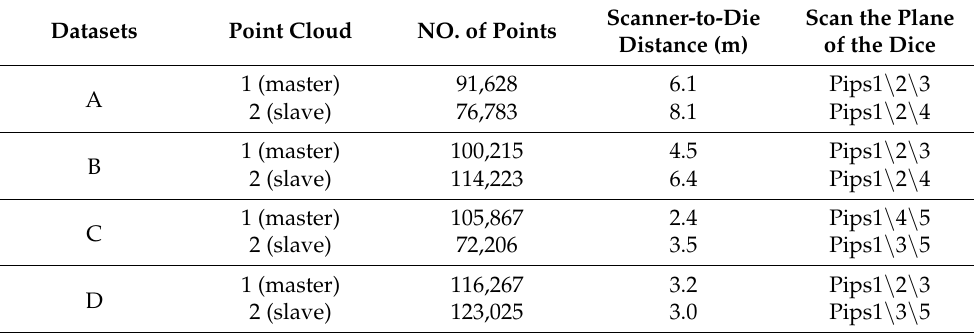
Figure 11. Scanning for point cloud datasets: ( a ) Dataset A; ( b ) Dataset B; ( c ) Dataset C; ( d ) Dataset D. Table 1. Details for the datasets collected for the registration.